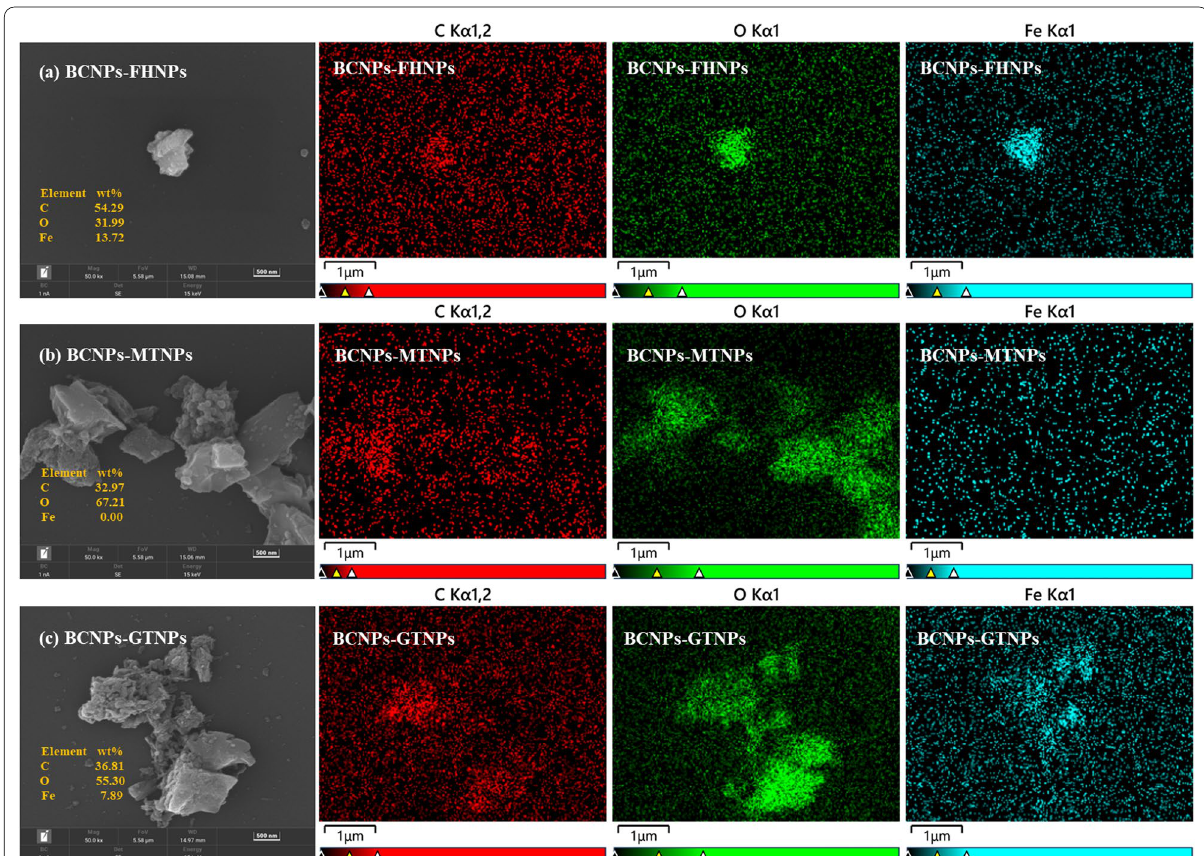
Fig. 4 Morphology and elemental mapping (red stands for C, green stands for O, and cyan stands for Fe) of BCNPs-IMNPs (BC 0.1 g and IM 0.02 g) mixed systems at pH 7.0 and at time t 200 =